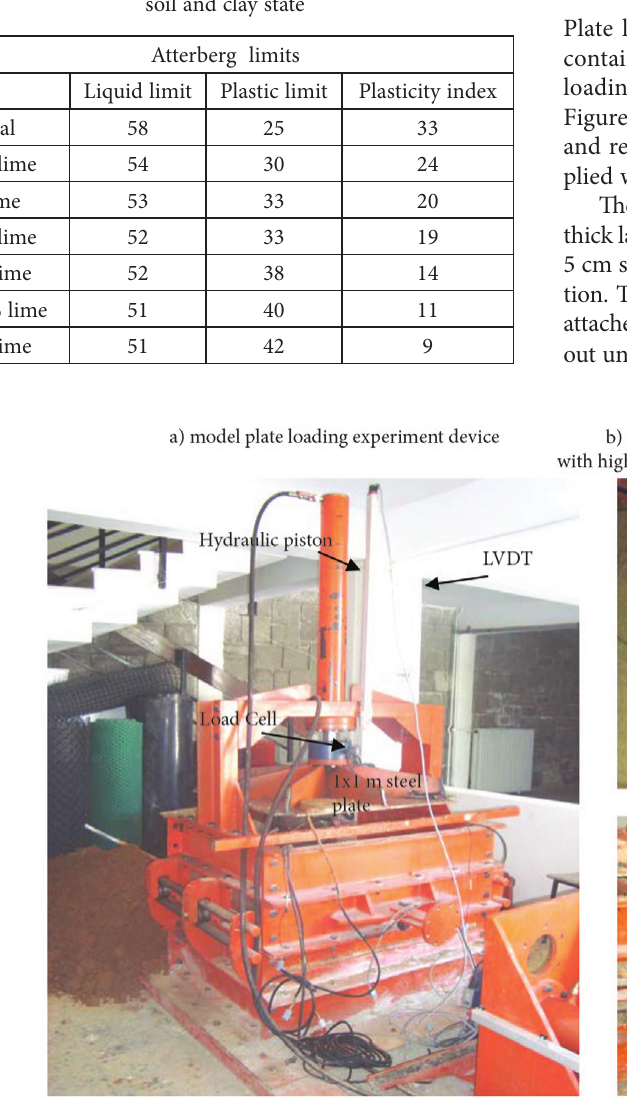
Figure 5. The plate loading experiment